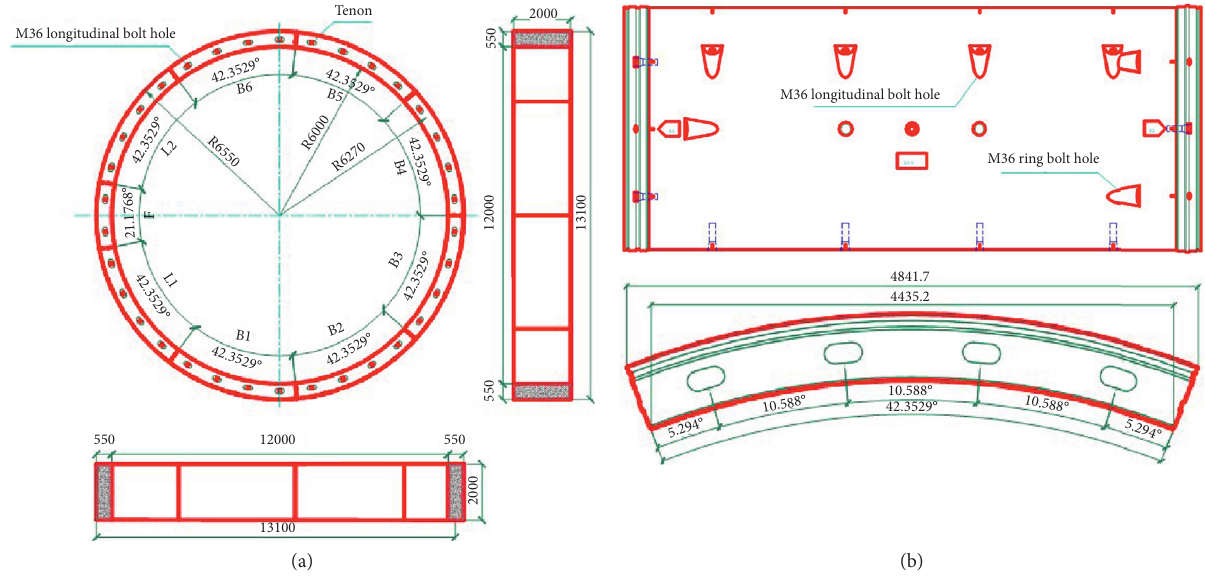
Figure 3: Diagram of the segment structure (mm). (a) Schematic diagram of the segments; (b) schematic of the detailed segment